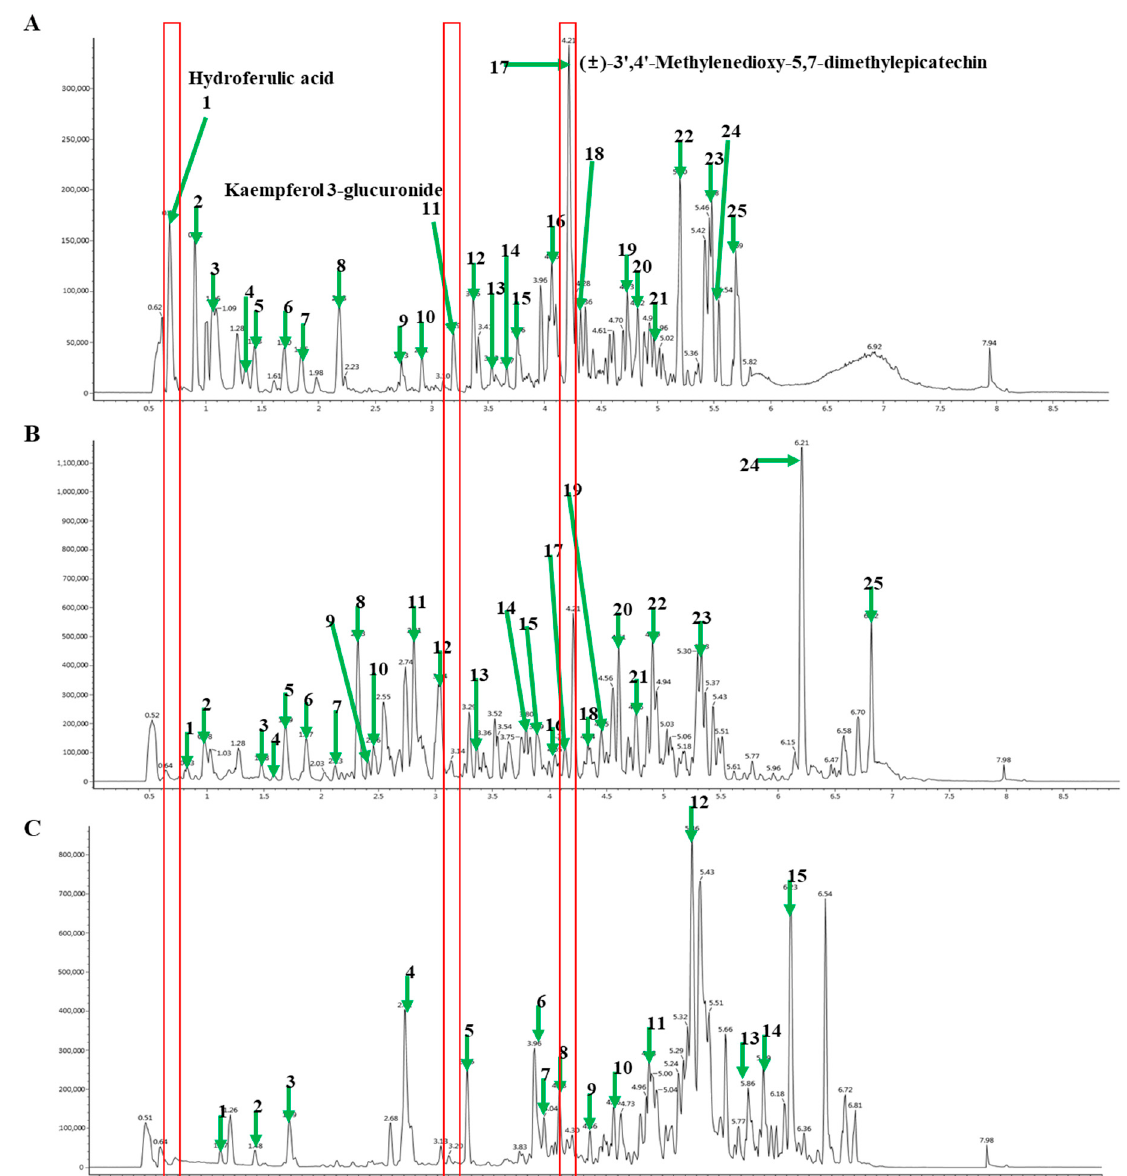
Figure 3. Representative ultra-performance liquid chromatography-quadrupole-time-of-flight mass spectrometry (UPLC-Q- TOF MS) profiles of M. charantia leaf. ( A ), D.W extract; ( B ), EtOH extract; and ( C ), hexane extract analyzed by ESI-negative mode (numbering in every panel is